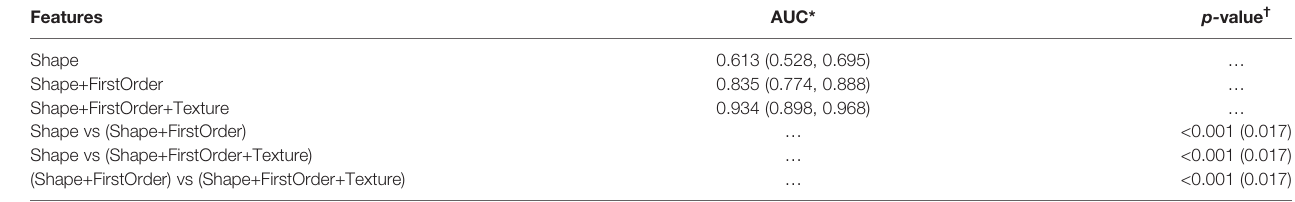
TABLE 3 | Classi fi cation performance of selected shape feature, fi rst order features, and texture features in classifying malignancies and benign lesions in the training set.